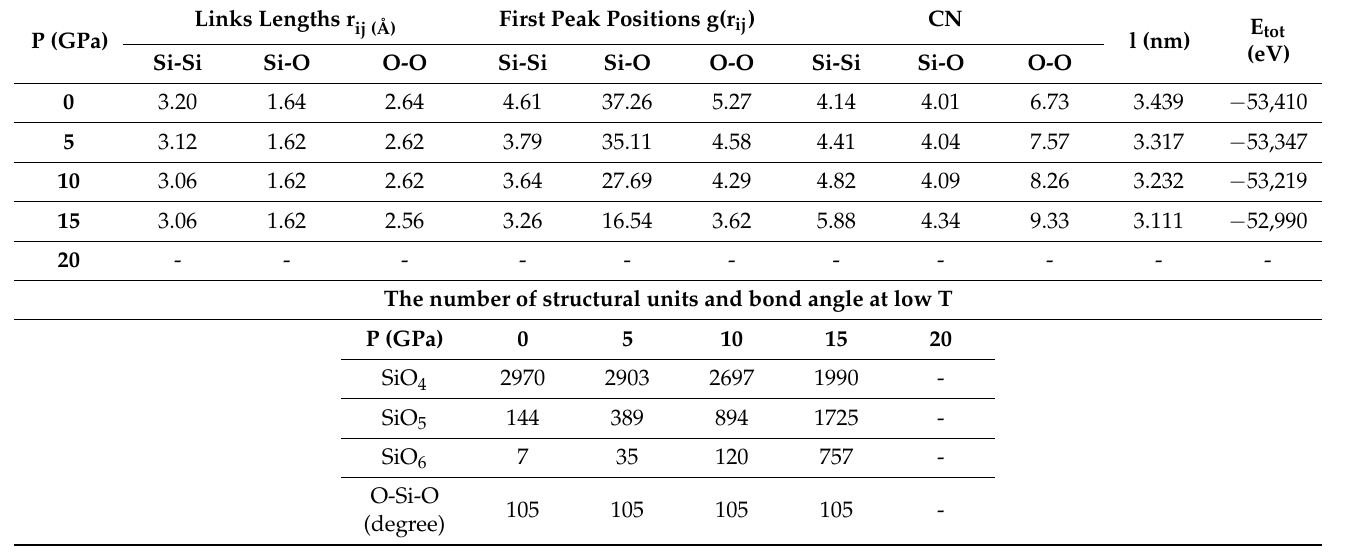
Table 6. The structural characteristic quantity of bulk SiO 2 at low T